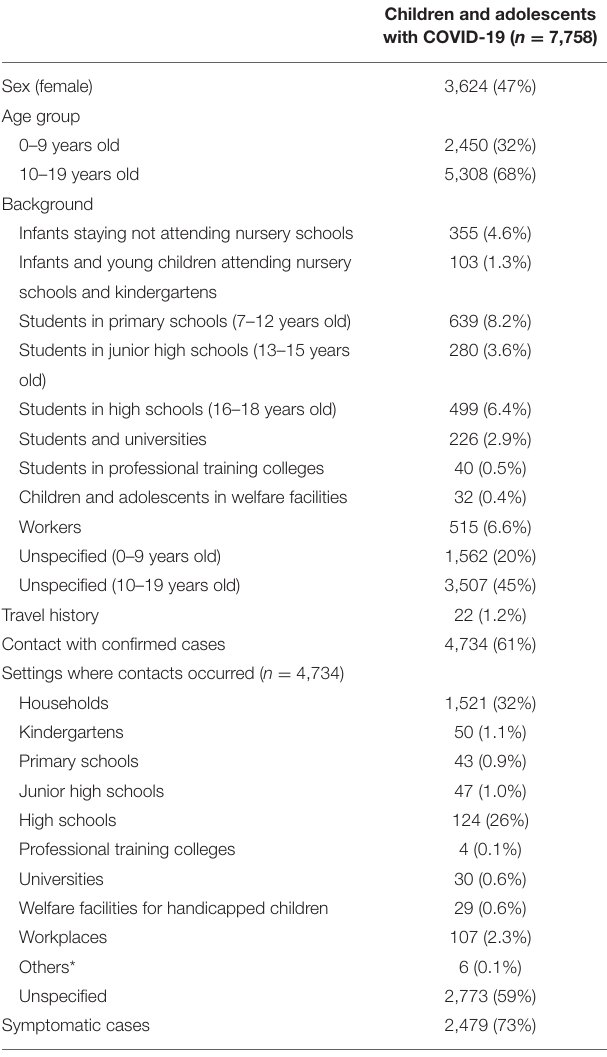
TABLE 1 | Characteristics of children and adolescents with